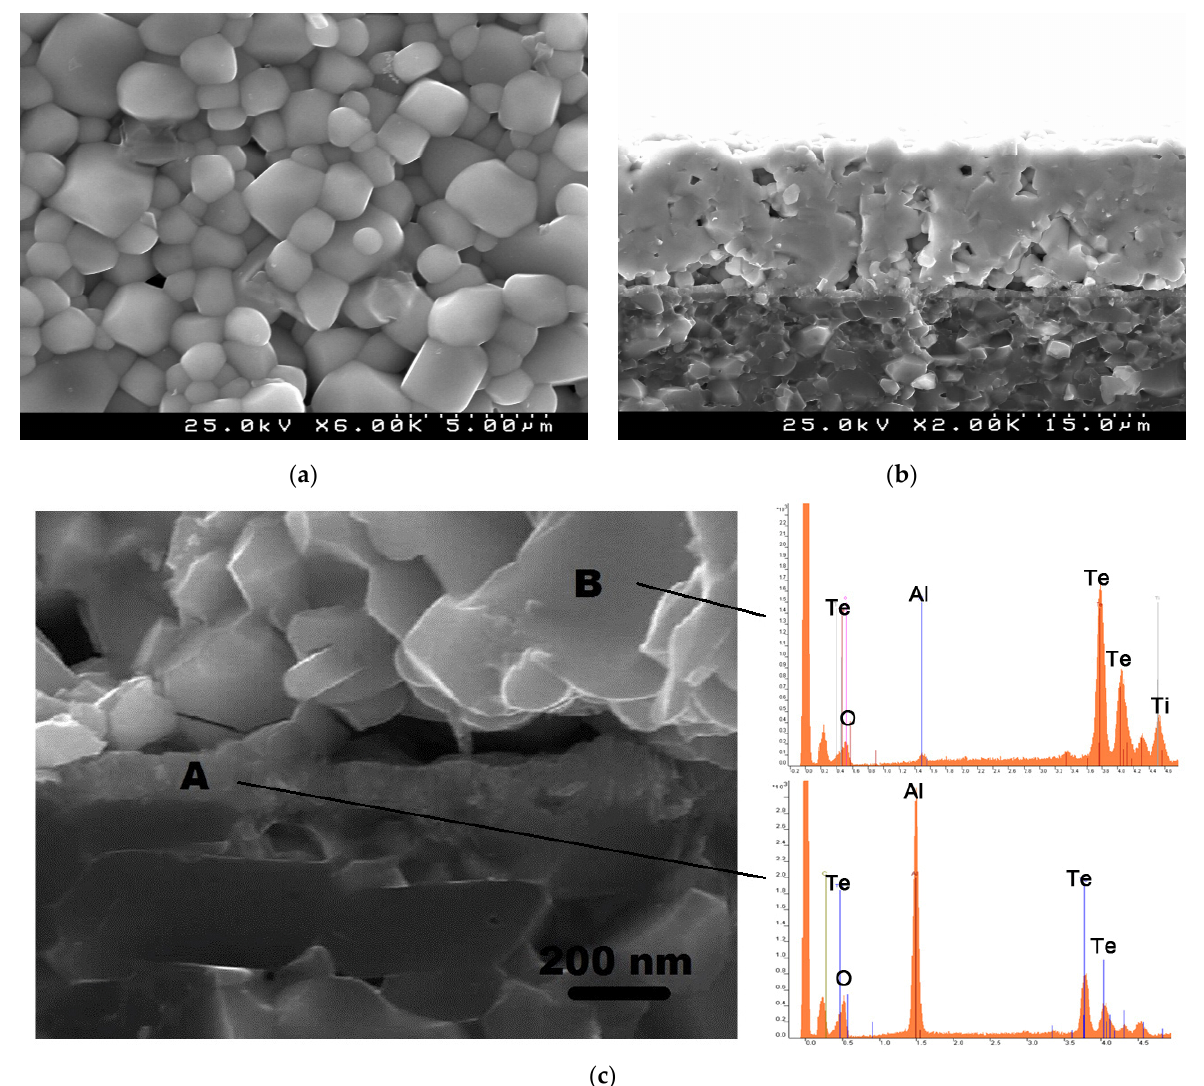
Figure 4. SEM micrographs of TiTe 3 O 8 films deposited on carbon coated alumina substrates sintered at 700 °C for 5 h, surface ( a ), cross section ( b ) and high magnification cross section and energy dispersive spectra for indicated locations ( c ). Under these sintering conditions (700 °C for 5 h in air) TiTe 3 O 8 films are dense and uniform with the presence of a thin (<200 nm) reaction interlayer of Al 2 TeO 6 confined to the interface between the film and the substrate.